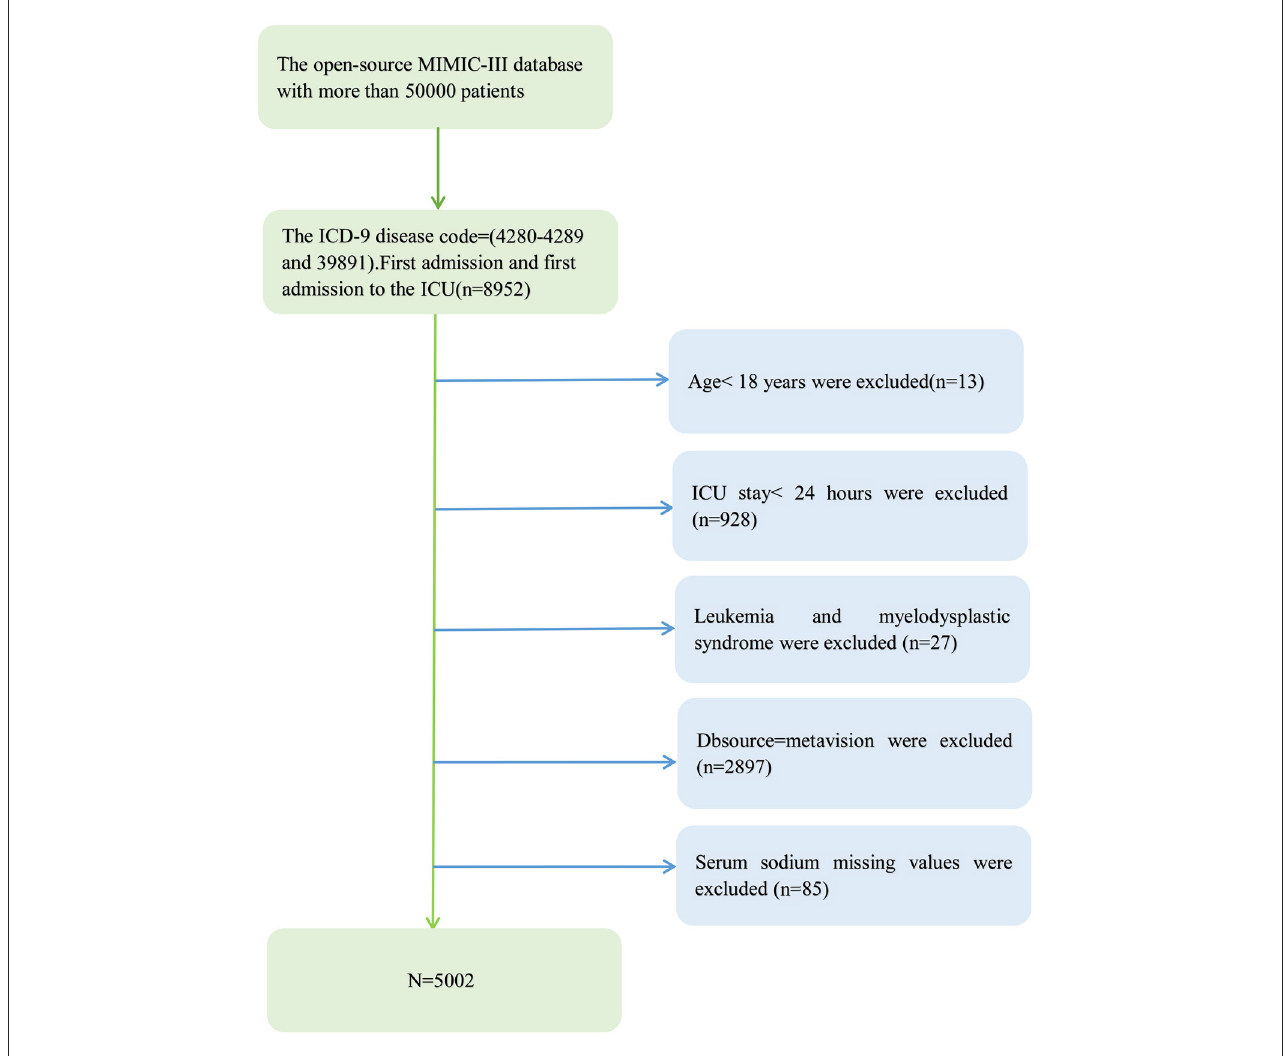
FIGURE1 Flowchart of patient selection.